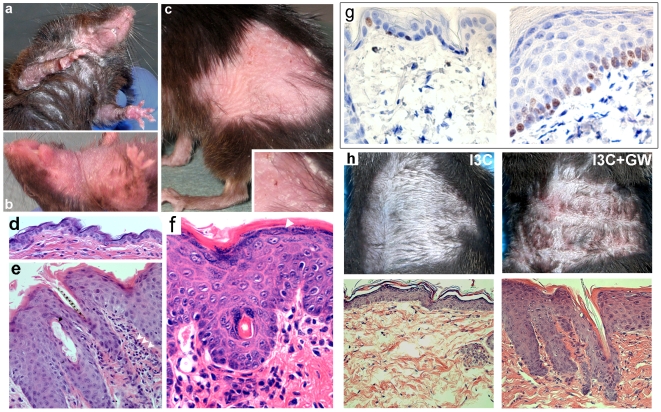
Skin phenotype in PPARβ/δ TG mice twenty days after GW501516 (GW) administration for twenty days.(a–c) Gross morphology, (d–e) H&E histology of control mice not treated with GW (d), or fourteen days after induction (e–g). Magnification 200× (d,e) or 400× (f). The white arrowhead in (f) denotes the granular layer. (g) Immunostaining for Ki67 of skin from PPARβ/δ TG mice maintained in the absence (left) or presence (right) of GW. Magnification 200×. (h) Induction of skin disease by topical application of either 0.3% of indole-3-carbinole (I3C, left) or I3C plus 0.3% GW501516 once daily to shaved abdominal skin. Gross macroscopic phenotype (top) and H&E histology of treated skin (bottom) was documented 10 days after beginning of treatment.